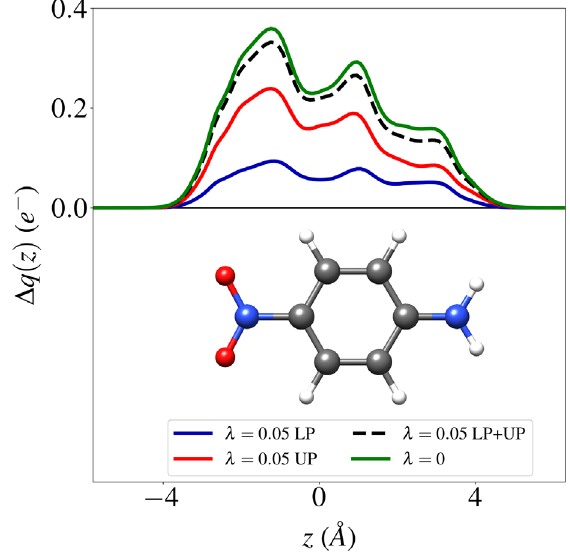
FIG. 5. QED-CCSD-1 excited-state charge displacement analy- sis of PNA with and without an optical cavity ( λ ¼ 0 . 05 and ω 4 . 84 eV). The charge displacement functions with the cav ¼ cavity for lower (LP, blue) and upper (UP, red) polaritons are shown. In green, we show the function for the charge transfer state without the cavity. The dashed black line represents the sum of the curves for LP and